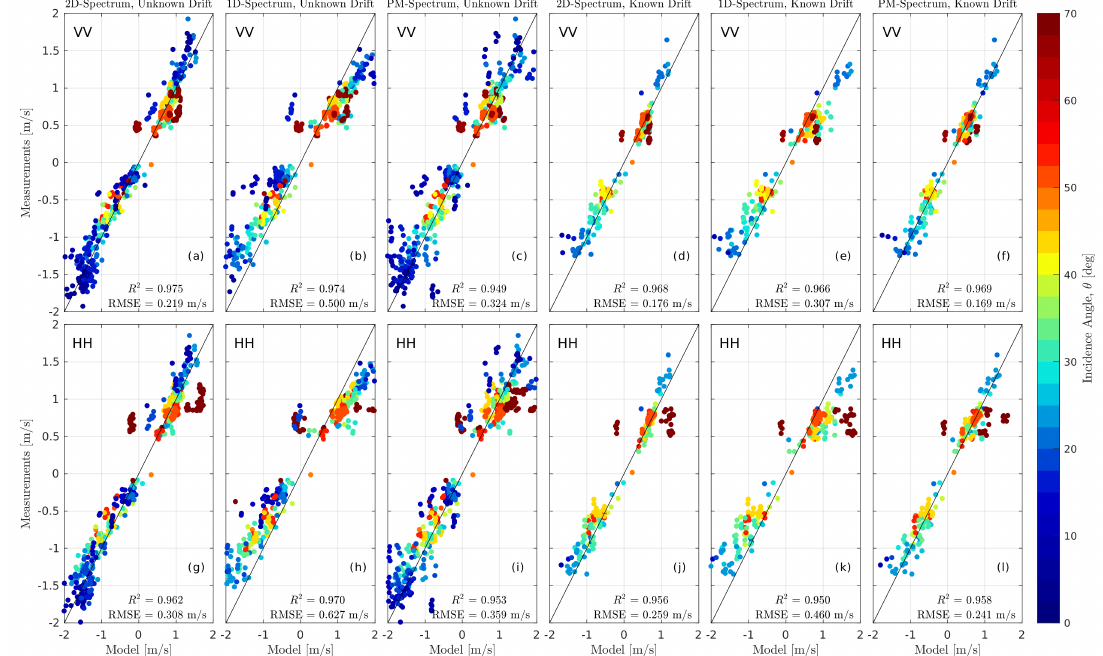
Figure 7. Model versus measurement DC range projection, V / sin θ . ( top row ) VV-polarization, ( bottom row ) HH-polarization. ( left three columns ) correspond to cases with unknown wind drift (estimated as 1.5% U ). Left to right: 2D-sea, Equation (14); 1D-sea, Equation (14); equivalent Pierson–Moskowitz (PM) spectral shape, Equation (16). ( right three columns ) are the same, but for cases with known wind drift. Correlation coefficient, R 2 , and root-mean-square error (RMSE) are shown in each